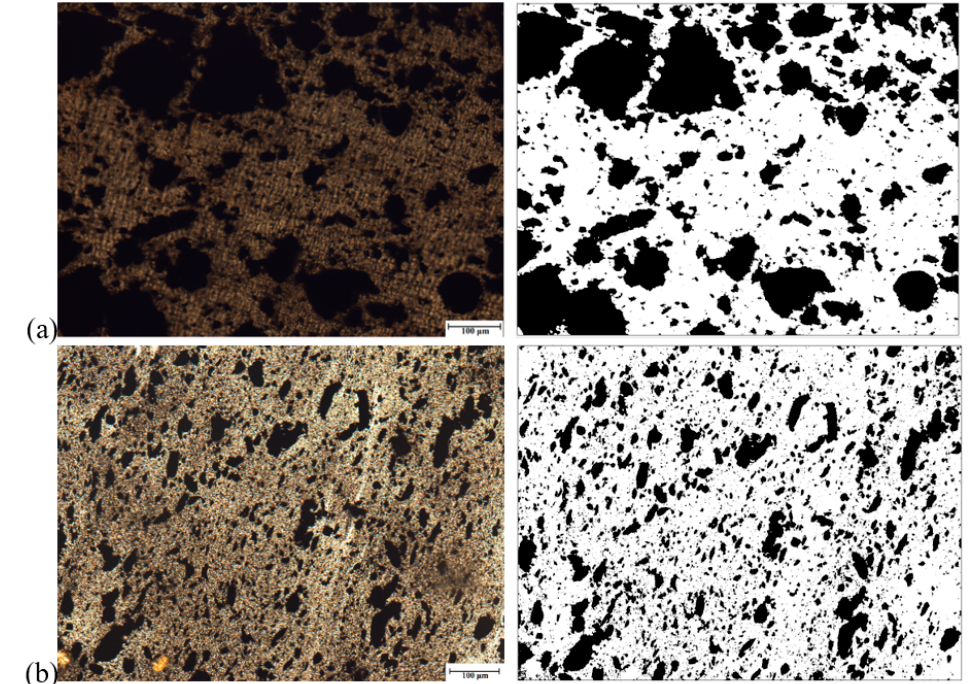
Figure 19. Optical micrographs of PP/EPDM 75/25 blends without ( a ) and with ultrasonic treatment at an amplitude of 13 μ m ( b ) prepared by the DR method (Right micrographs were treated by the ImageJ software).